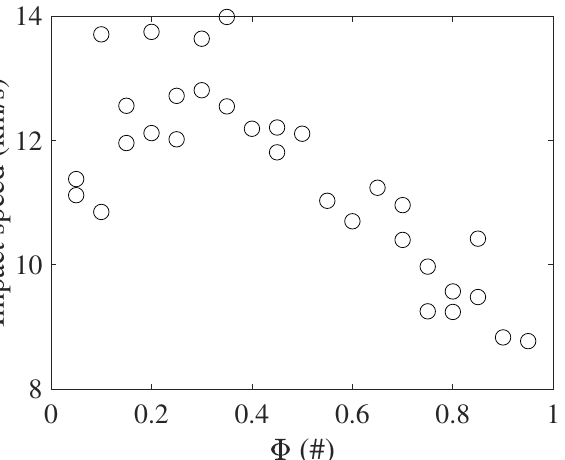
Figure 3. Variation of the impact speed with the selection variable, Φ ( C 3 = 4.676 km 2 s − 2 , P source = 7330 W, and m prop = 150 kg).